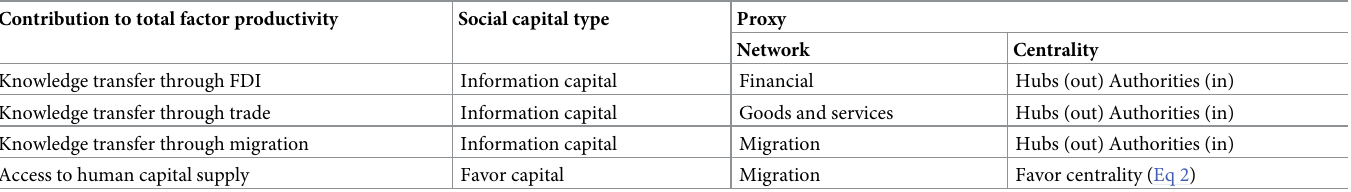
Table 1. Proposed relationship between different TFP growth factors and the different types of social capital in the different